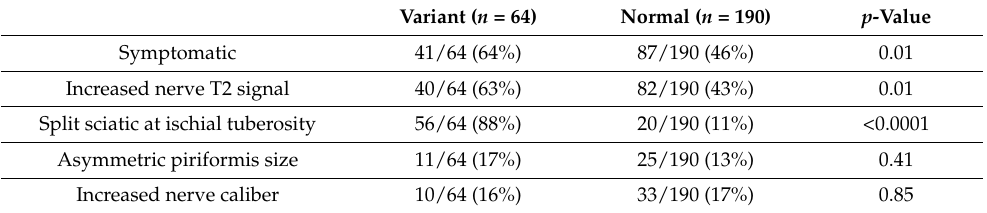
Table 3. Sciatic nerve type and correlation with clinical and imaging characteristics.